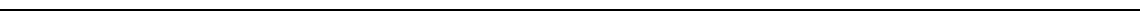
Fig. 9 Caspase-1 inhibitors YVAD or VAD and mMCAD-transduced BMDMs suppress tumor growth. a Representative photographs of tumors in MMTV-PyMT mice. Scale bar, 2 cm. b Tumor weight was analyzed ( n = 6). c Body weight of tumor-bearing mice was analyzed ( n = 6). d Expression of TAM hallmarks was assessed by RT-qPCR ( n = 3). e , f Tumor weight and body weight were measured ( n = 7). g Representative photographs of tumors were taken. Scale bar, 2 cm. h Cryosections were prepared, the in fi ltration of MCAD-transduced BMDMs was observed via immuno fl uorescence with anti- HA antibodies ( green ). Scale bars, 75 μ m. i Lysates of TAMs isolated from 4T1 tumor-bearing mice that infused with MCAD-transduced BMDMs mice or LacZ-transduced BMDMs were prepared, MCAD protein content was analyzed with an anti-HA antibody or anti-MCAD antibody. j Representative dot plots (logarithmic scale) of Nile Red fl uorescence versus forward scatter (FCS-H) in TAMs isolated from 4T1 tumor-bearing mice that infused with LacZ-transduced BMDMs (TAMs-LacZ) or MCAD-transduced BMDMs (TAMs-MCAD) were shown, non-Nile Red stained TAMs isolated from 4T1 tumor-bearing mice that infused of LacZ-transduced BMDMs as control (Non-Nile Red). k Lipid content in TAMs isolated from 4T1 tumor-bearing mice that infused with MCAD-transduced BMDMs or LacZ-transduced BMDMs were analyzed by a quanti fi cation method ( n = 7). l Phagocytic abilities of TAMs isolated from 4T1 tumor-bearing mice that infused with MCAD-transduced BMDMs (TAMs-MCAD) or LacZ-transduced BMDMs (TAMs-LacZ) were analyzed with latex beads, TAMs-LacZ incubated with the vehicle as the negative control (Non-Latex beads). m Pro-tumoral genes expression of TAMs isolated from 4T1 tumor-bearing mice that infused with MCAD-transduced BMDMs (TAMs-MCAD) or LacZ-transduced BMDMs (TAMs-LacZ) were analyzed with RT-qPCR, peritoneal macrophages isolated from 4T1 tumor-bearing mice that infused of LacZ-transduced BMDMs as control (PM-LacZ; n = 3). All the histograms in this fi gure show means ± s.e.m. ( n = 3, * P < 0.05, ** P < 0.01, *** P < 0.001, ns, not signi fi cant, one way ANOVA